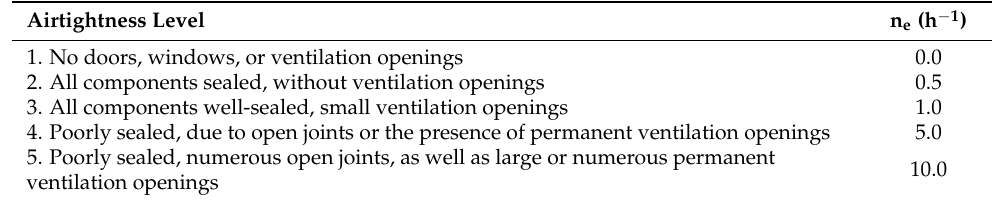
Table 9. Air renewal rate between non-habitable spaces and the exterior, set by the DB-HE (adapted from